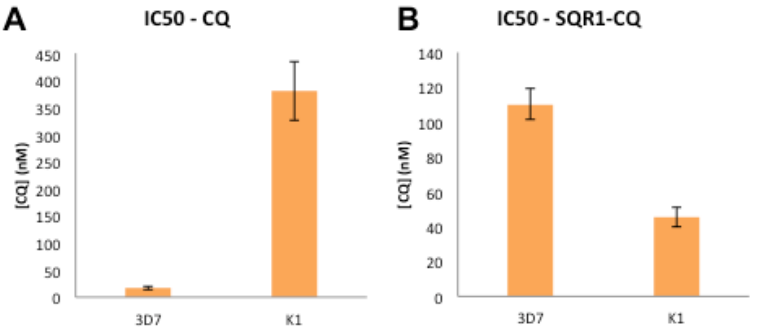
Figure 4. Anti- P. falciparum efficacy by IC50 calculation. ( A ) IC50 of CQ against resistant strain K1 (379.83 nM ± 54.62) over 20-fold higher than IC50 of CQ (16.27 nM ± 3.73) against chloroquine- sensitive strain 3D7. ( B ) SQR1-CQ IC50 against chloroquine-resistant P. falciparum laboratory strain K1 (45.5 nM ± 5.60) nearly 3-fold lower than SQR1-CQ IC50 against 3D7 (110.37 nM ± 9.21). Data shown are mean IC50 values from at least 3 independent experiments. Error bars indicate standard error of the mean.